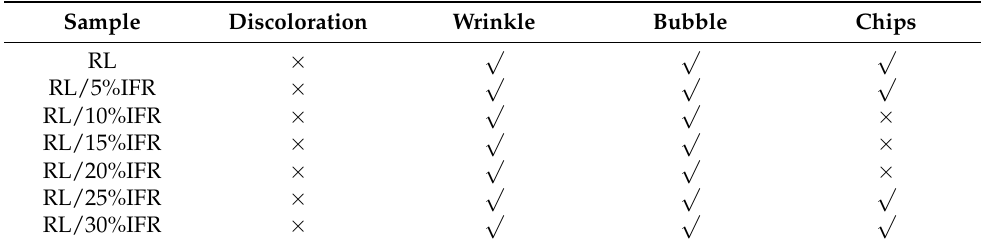
Table 7. Alkaline resistance of RL/IFR